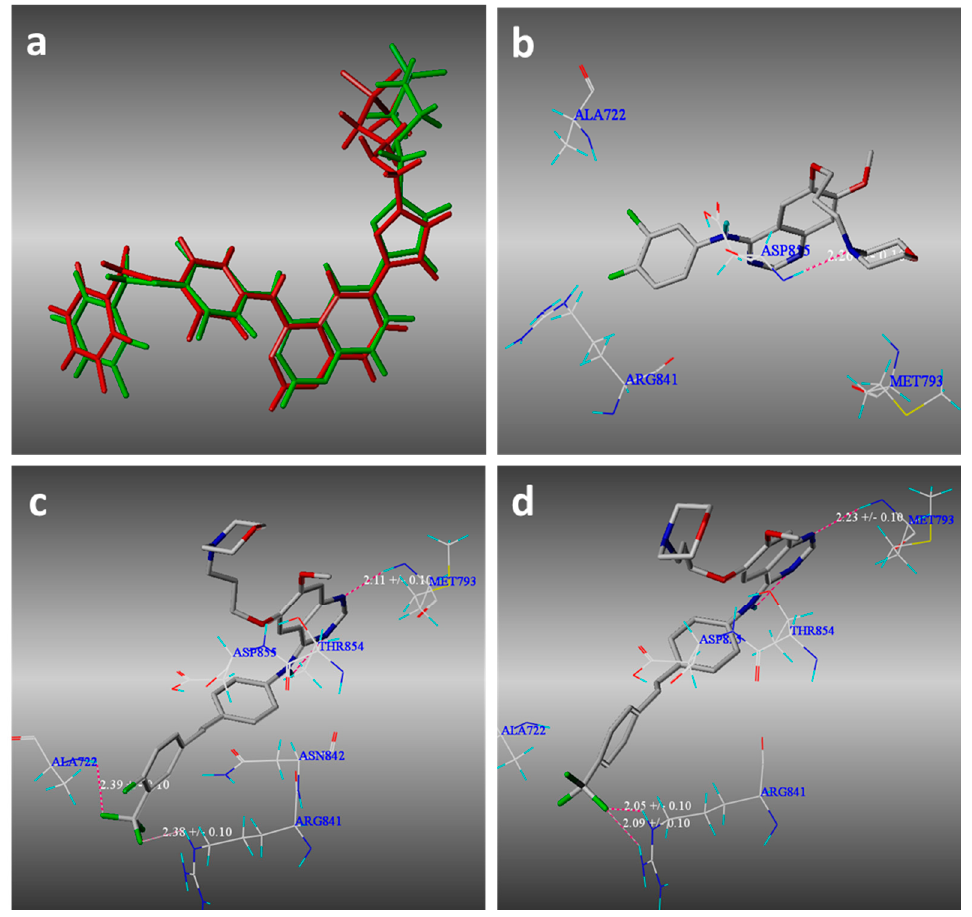
Figure 2. Gradient-optimized pose of Lapatirib (red) versus crystallographically determined structure (green) ( a ). Docking of compounds Gefitinib ( b ), 6i ( c ), and 6c ( d ) into the active site of epidermal growth factor receptor (EGFR).